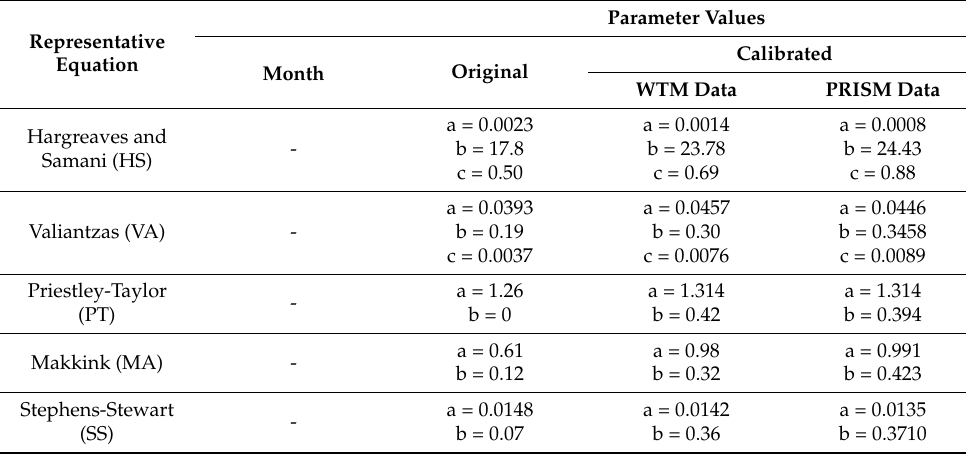
Table 1. Original and calibrated coefficient values of the selected empirical